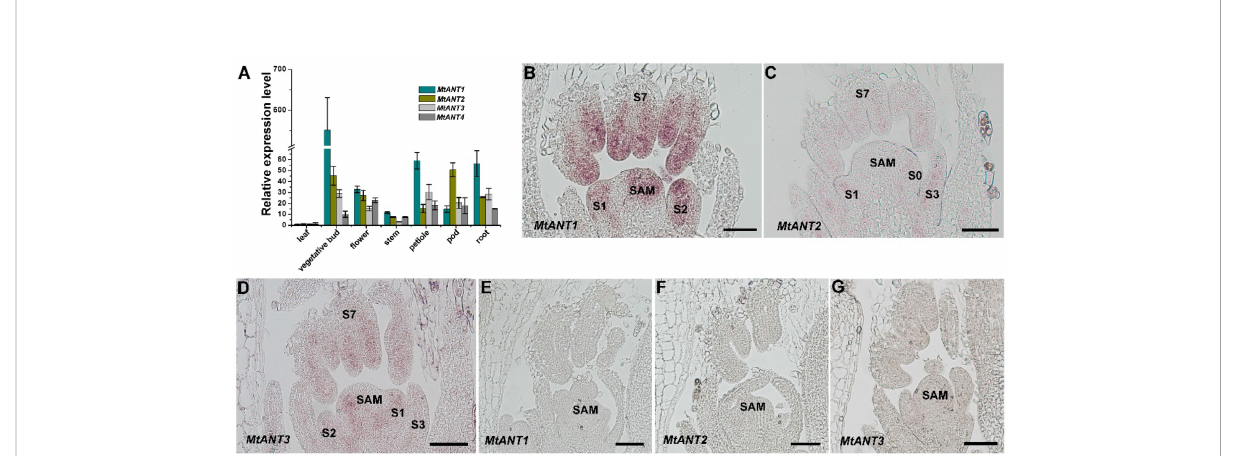
FIGURE 4 Expression patterns of MtANTs in M. truncatula . (A) qRT-PCR analysis of MtANTs expression in different organs. MtUBIQUITIN was used as the internal control. Bars represent means ± SD of three biological replicates. (B-D) In situ hybridization analysis of MtANT1 (B) , MtANT2 (C) and MtANT3 (D) in the vegetative buds of wild type. Longitudinal sections of SAM and leaf primordia at the different developmental stages are shown. SAM, shoot apical meristem; S, stage. Bars = 100 m m. (E – G) The sense probes were used as the negative controls. SAM, shoot apical meristem; Bars = 100 m m.